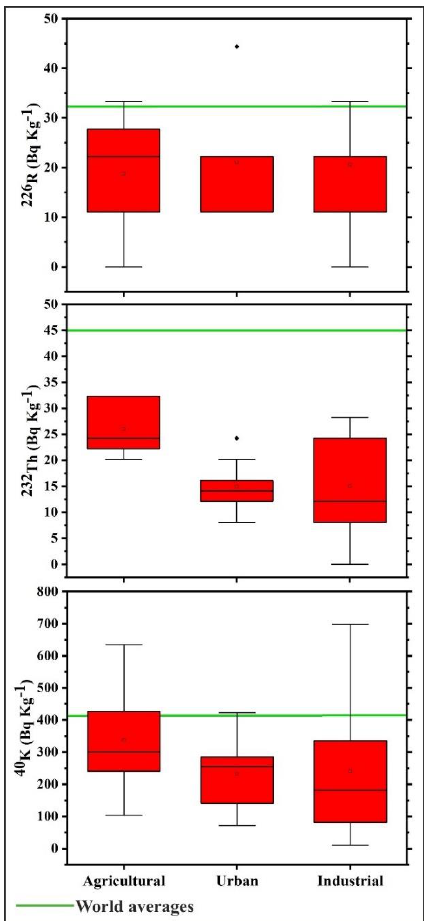
Figure 4. Boxplot of 226 Ra, 232 Th, and 40 K activity concentrations in the studied soil.